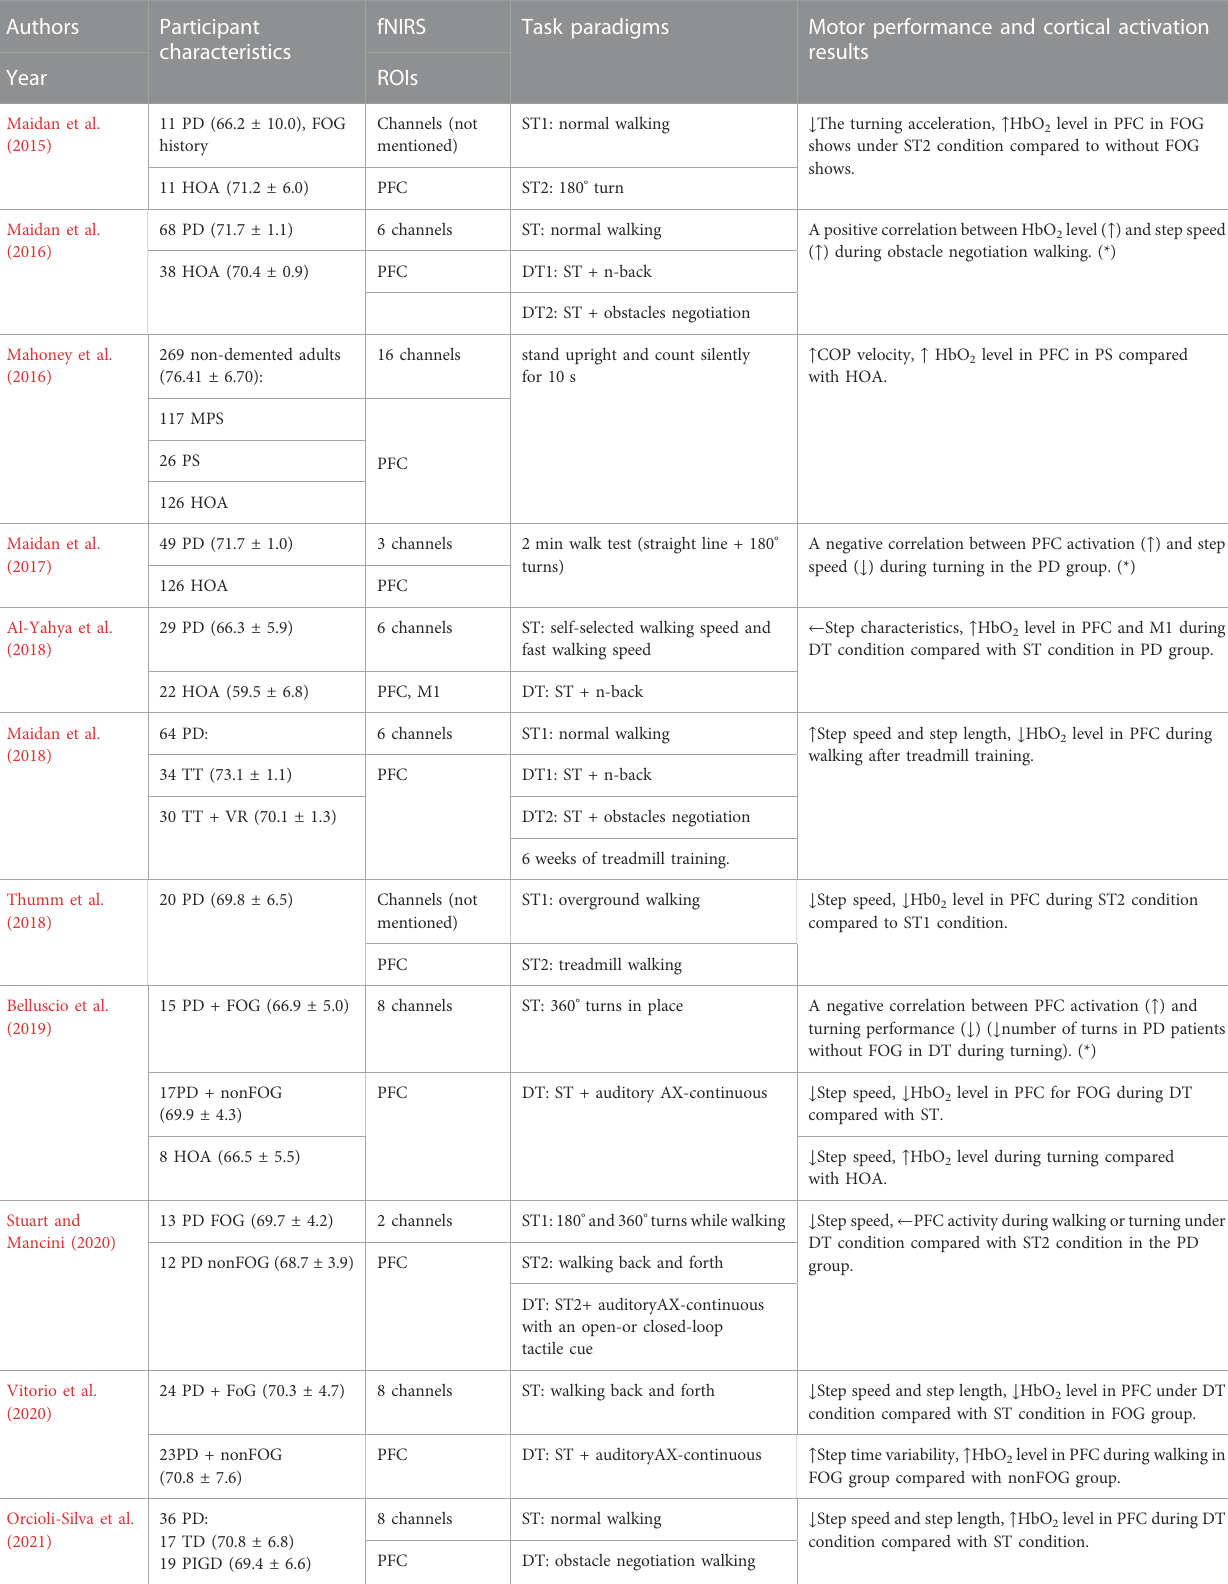
TABLE 1 Summary of motor performance and cortical activation outcomes in studies of Parkinson ’ s patients.